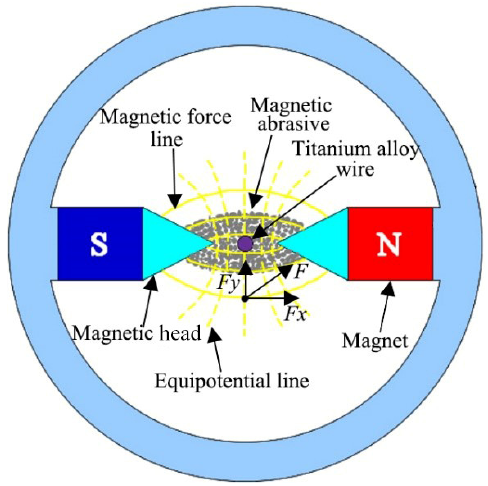
Figure 1. Schematic of processing principle for an magnetic abrasive finishing.